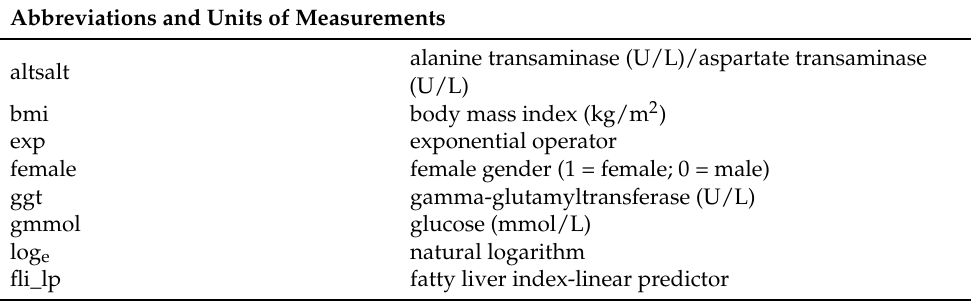
Table A3. Multivariable Prediction Models Employed by the Biomarkers. Abbreviations and Units of